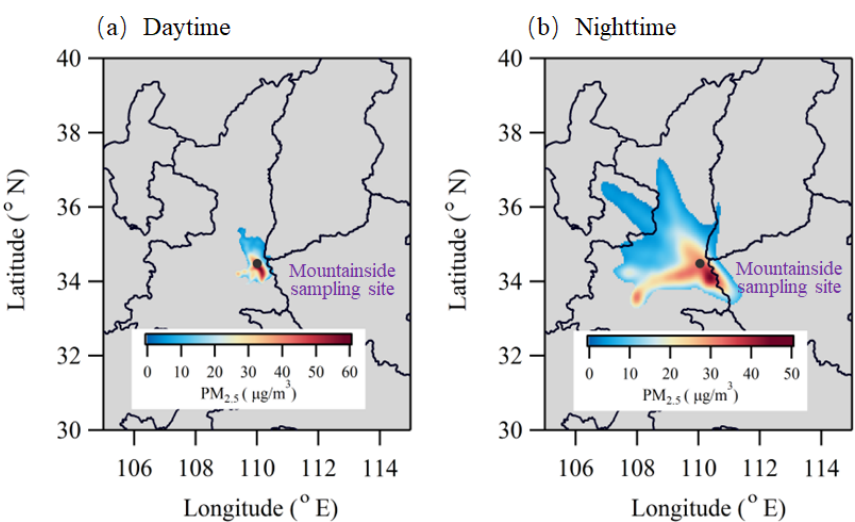
Figure 4. Concentration-weighted trajectory (CWT) analyses of PM 2 . 5 in the daytime (08:00–20:00) and nighttime (21:00–07:00) at the MS